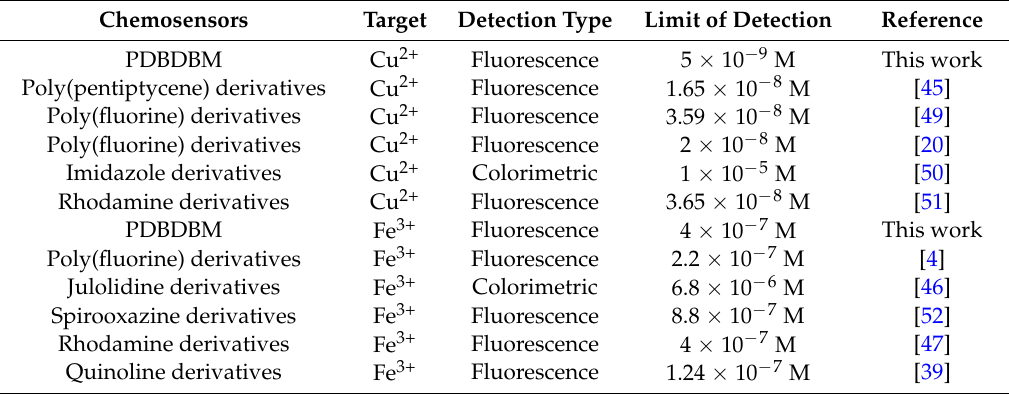
Table 1. Comparison of PDBDBM with recently reported chemosensors.